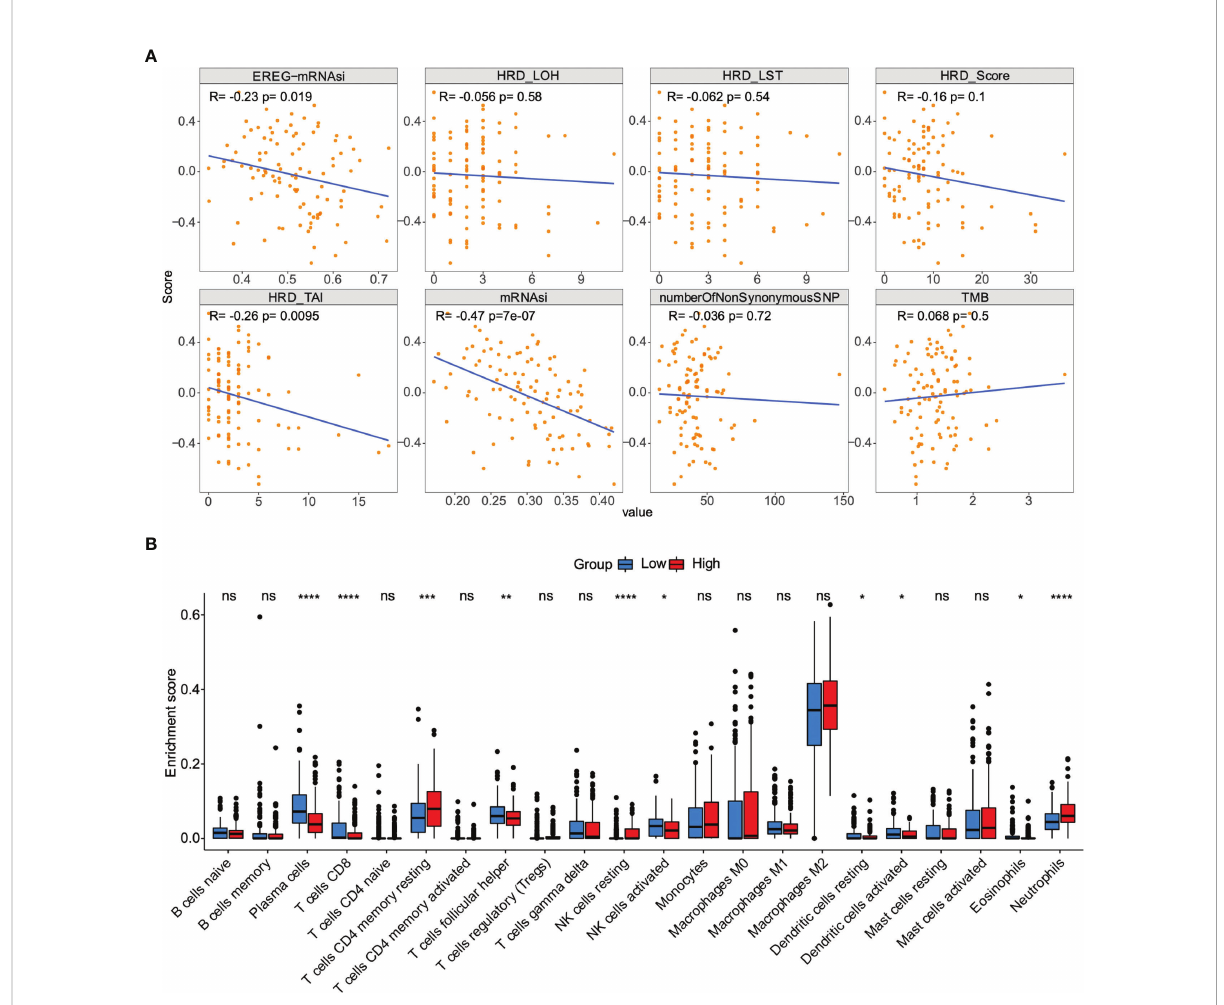
FIGURE 8 The association between the risk score and genetic characteristics and in fi ltration immune cells. (A) Correlation between risk score and some potential factors which determine tumor immunogenicity, including stemness index, chromosome instability level, homologous recombination defect, neoantigen load, and mutation load. (B) Compositions of in fi ltration immune cells between high ‐ and low ‐ risk groups in the TCGA dataset. *p < 0.05, **p < 0.01, ***p < 0.001, ****p < 0.0001. ns, no signi fi